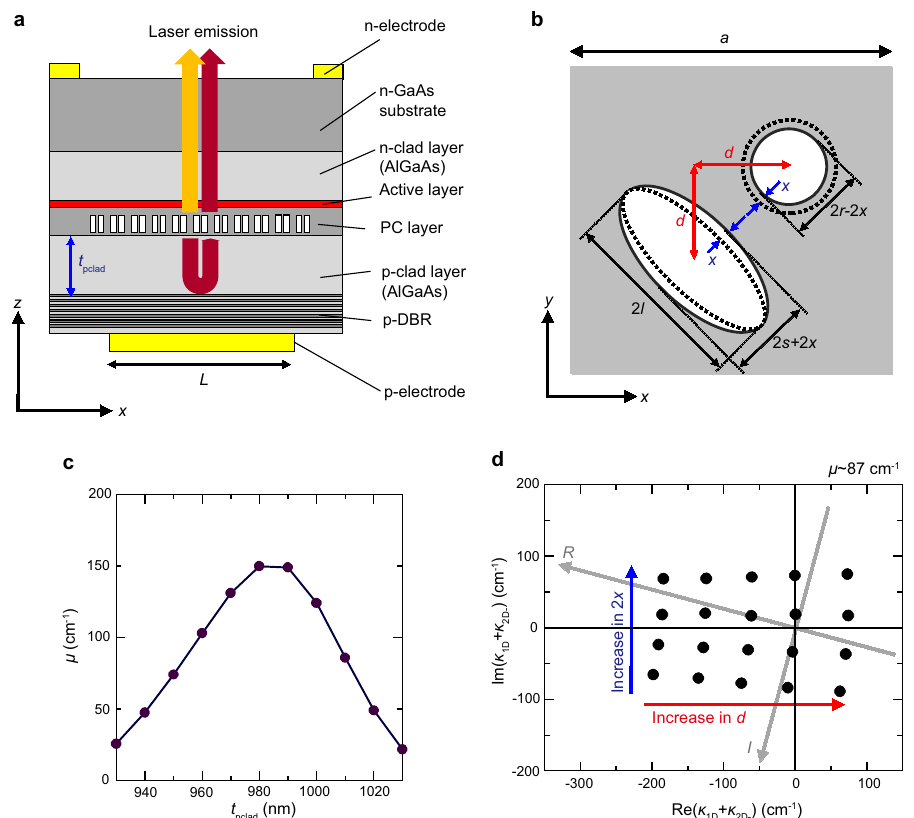
Fig. 5 Double-lattice PCSEL with Distributed Bragg Re fl ector (DBR) for arbitrary control of coupling coef fi cients. a Cross section of a double-lattice PCSEL with a DBR. b Top view of the double-lattice photonic crystal composed of an elliptical and circular hole. d is the lattice separation and 2 x is the tuning parameter for the hole sizes (or balance of large and small holes). The details of the parameters are explained in Supplementary Section 8. c Magnitude of non-Hermitian coupling coef fi cient μ as a function of the p-clad thickness t pclad . d Calculated Hermitian coupling coef fi cient ( κ 1D þ κ 2D (cid:2) or R and I ) in the complex plane, when d and 2 x are